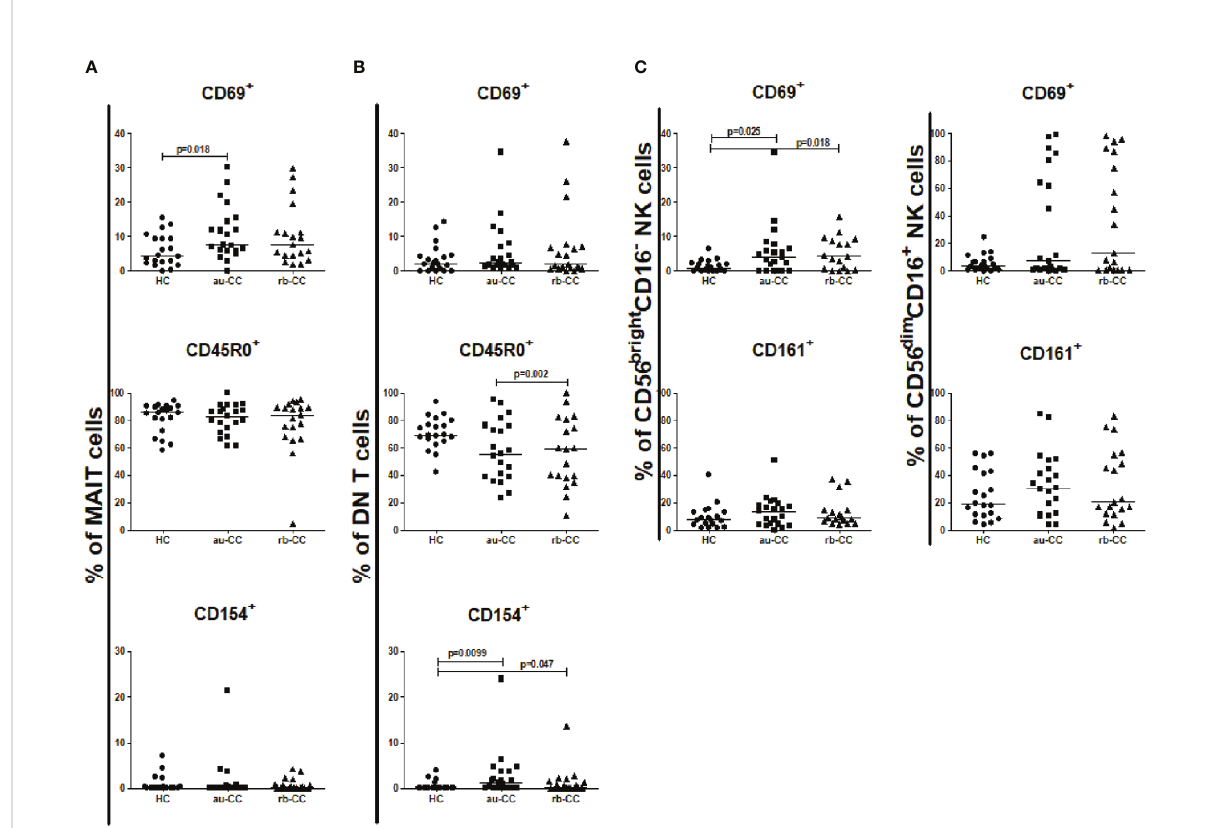
FIGURE 2 Frequencies of peripheral activated and memory subpopulations of MAIT cells (A) , DN T cells (B) , CD56brightCD16- and CD56dimCD16+ NK cells (C) in collagenous colitis. Analysis performed with fl ow cytometry. Statistically signi fi cant differences are p<0.01, statistical trends are p<0.05. au, active/untreated; CC, collagenous colitis; HC, healthy controls; rb, remission/budesonide.CD69, CD154 and CD161 are activation markers and CD45R0 memory